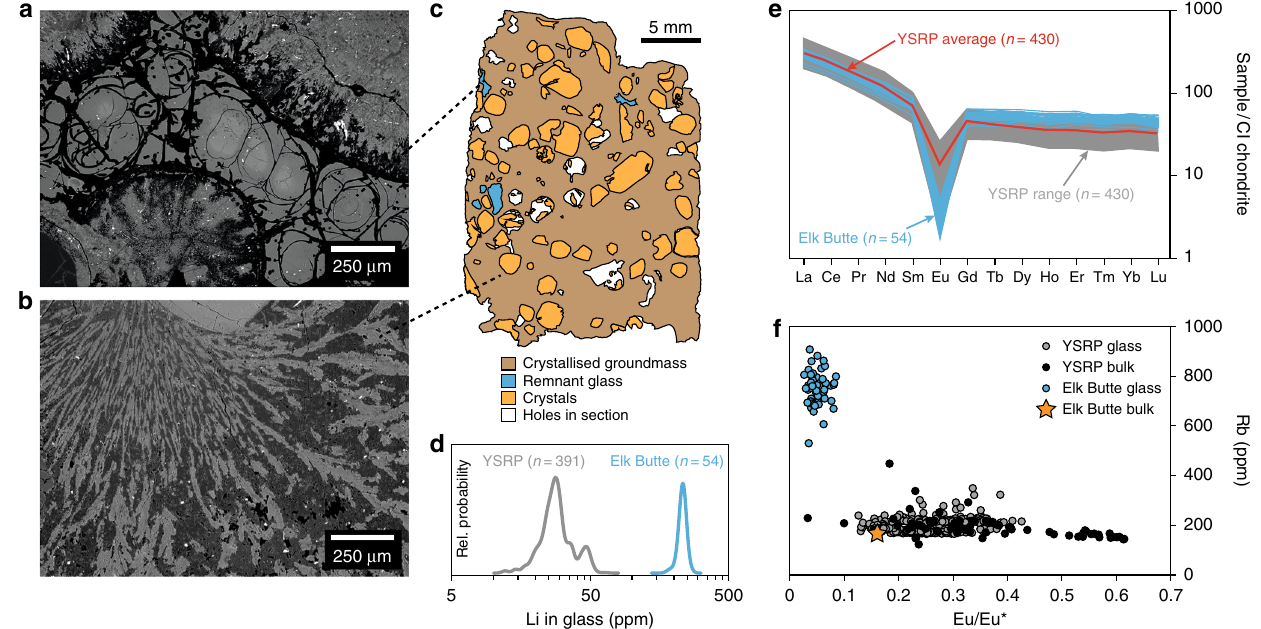
Fig. 6 Composition of last remnant glass prior to complete groundmass crystallisation (Elk Butte dome of the Island Park series 47 ). Small slivers of glass ( a ) represent the last remaining liquids in a dominantly crystallised groundmass ( b ). The remnant melt pockets in Elk Butte ( a , c ) have Li contents of the same magnitude as predicted in Fig. 5 ( d ) illustrating the geological reality of such a process. While these remnant glasses have similar characteristics to typical Yellowstone glasses ( e ), their trace elements re fl ect the extended crystallisation of the groundmass with elevated incompatible elements such as Li and Rb ( f